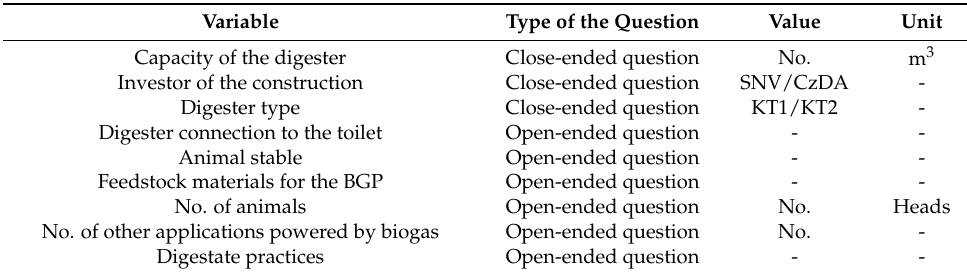
Table 2. Overview of variables in the questionnaire.